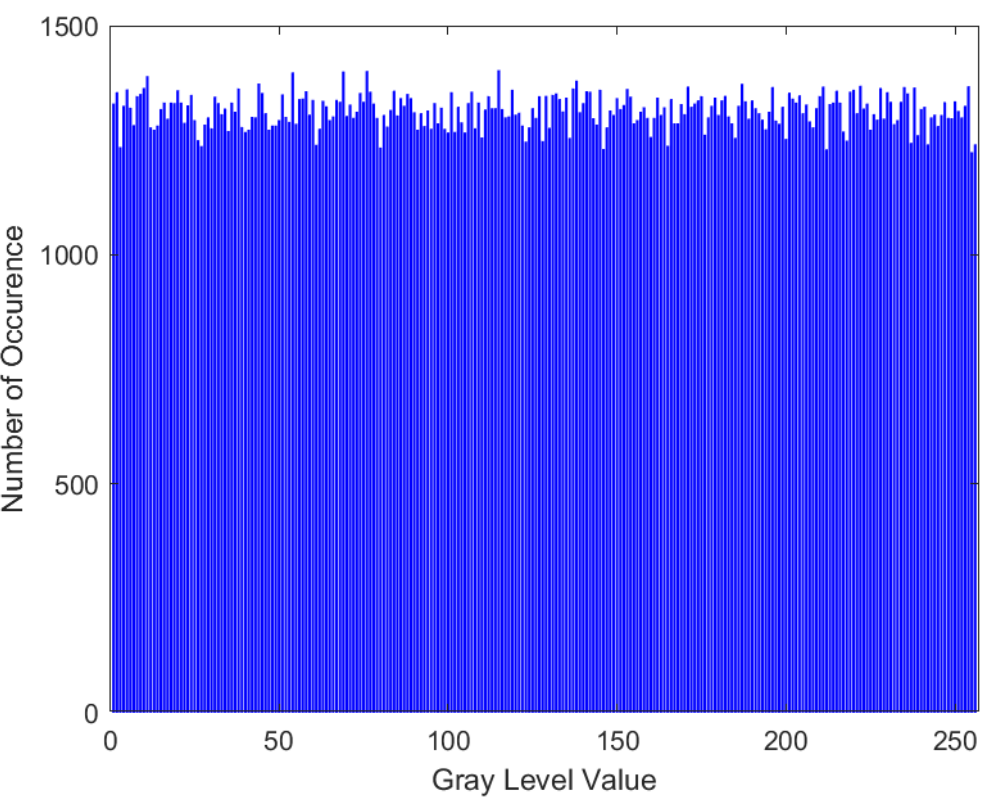
Figure 15. Histogram of the ciphertext: blue channel. Table 4. Security analyses of the encrypted spectrogram: red